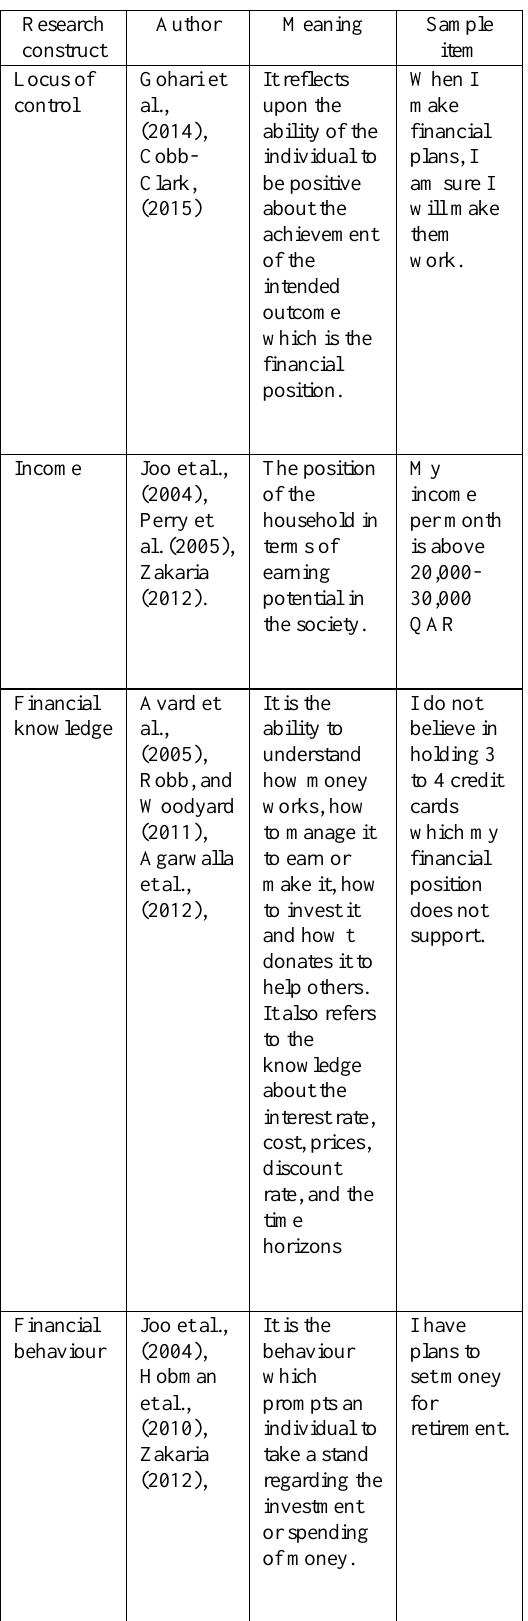
Table 1: Research Construct, Author, Meaning